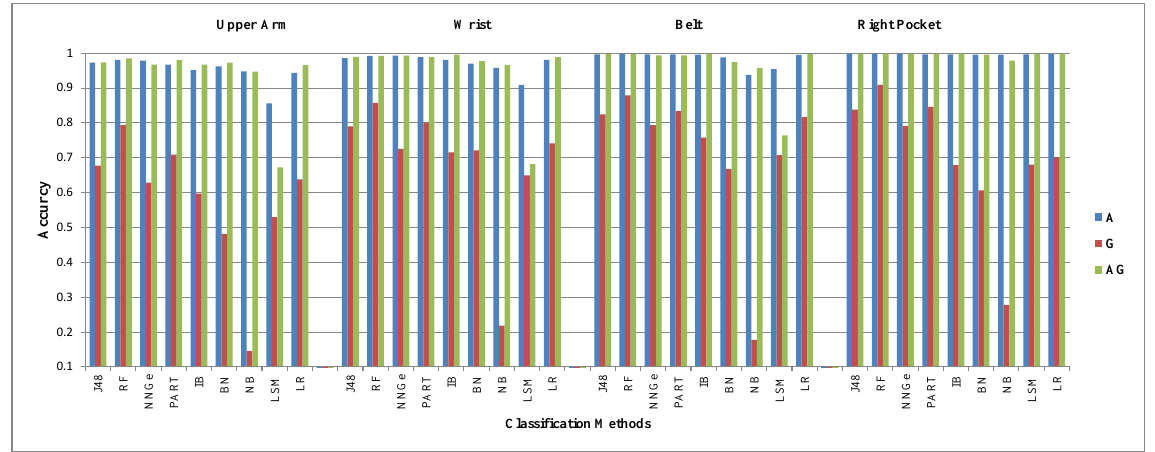
Figure A.4. Recognition performance for the standing activity at all four positions using